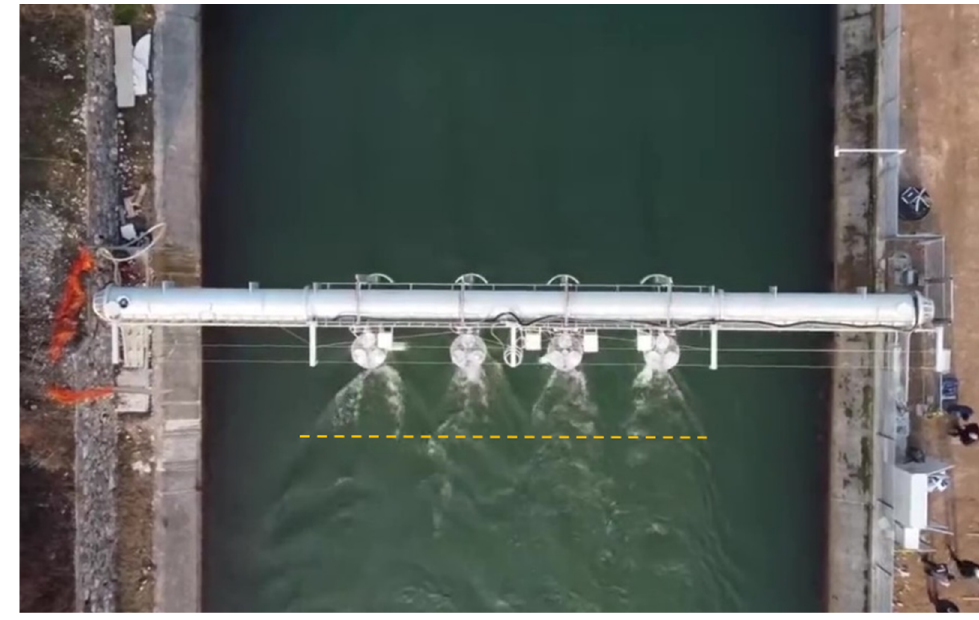
Figure 7. Near-wake distribution of four cross-flow turbines from [3].